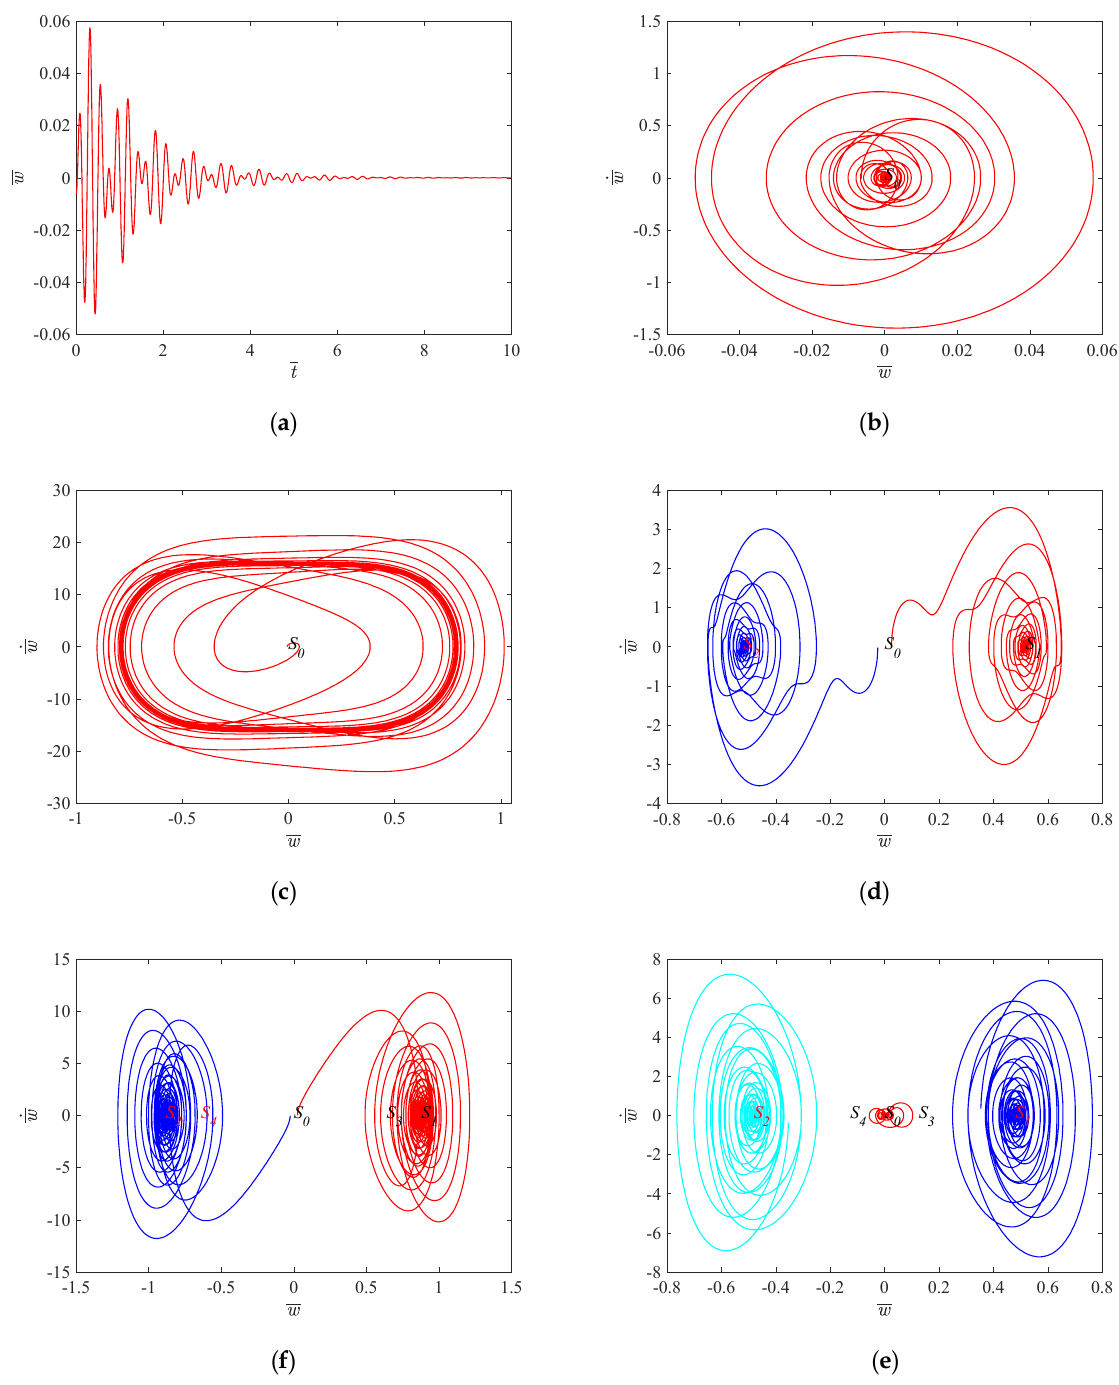
/ 0.01 M μ = Figure 9. Time history diagrams and phase trajectories for µ / M = 0.01. ( a ) Region I time history Figure 9. Time history diagrams and phase trajectories for . ( a ) Region Ⅰ time his- diagrams. ( b ) Region I phase trajectories and stable point. ( c ) Region II phase trajectories and stable tory diagrams. ( b ) Region Ⅰ phase trajectories and stable point. ( c ) Region Ⅱ phase trajectories point. ( d ) Region III phase trajectories and stable point. ( e ) Region IV phase trajectories and stable and stable point. ( d ) Region Ⅲ phase trajectories and stable point. ( e ) Region IV phase trajectories point. ( f ) Region EDG phase trajectories and stable and stable point. ( f ) Region EDG phase trajectories and stable point .